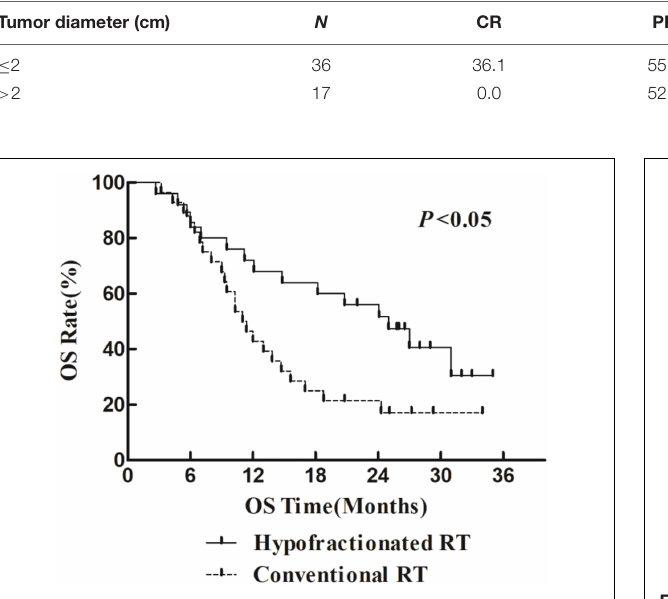
FIGURE 1 | Comparison of OS between HFR group and CFR group. Patients who received HFR treatment have better OS than those treated with CFR.